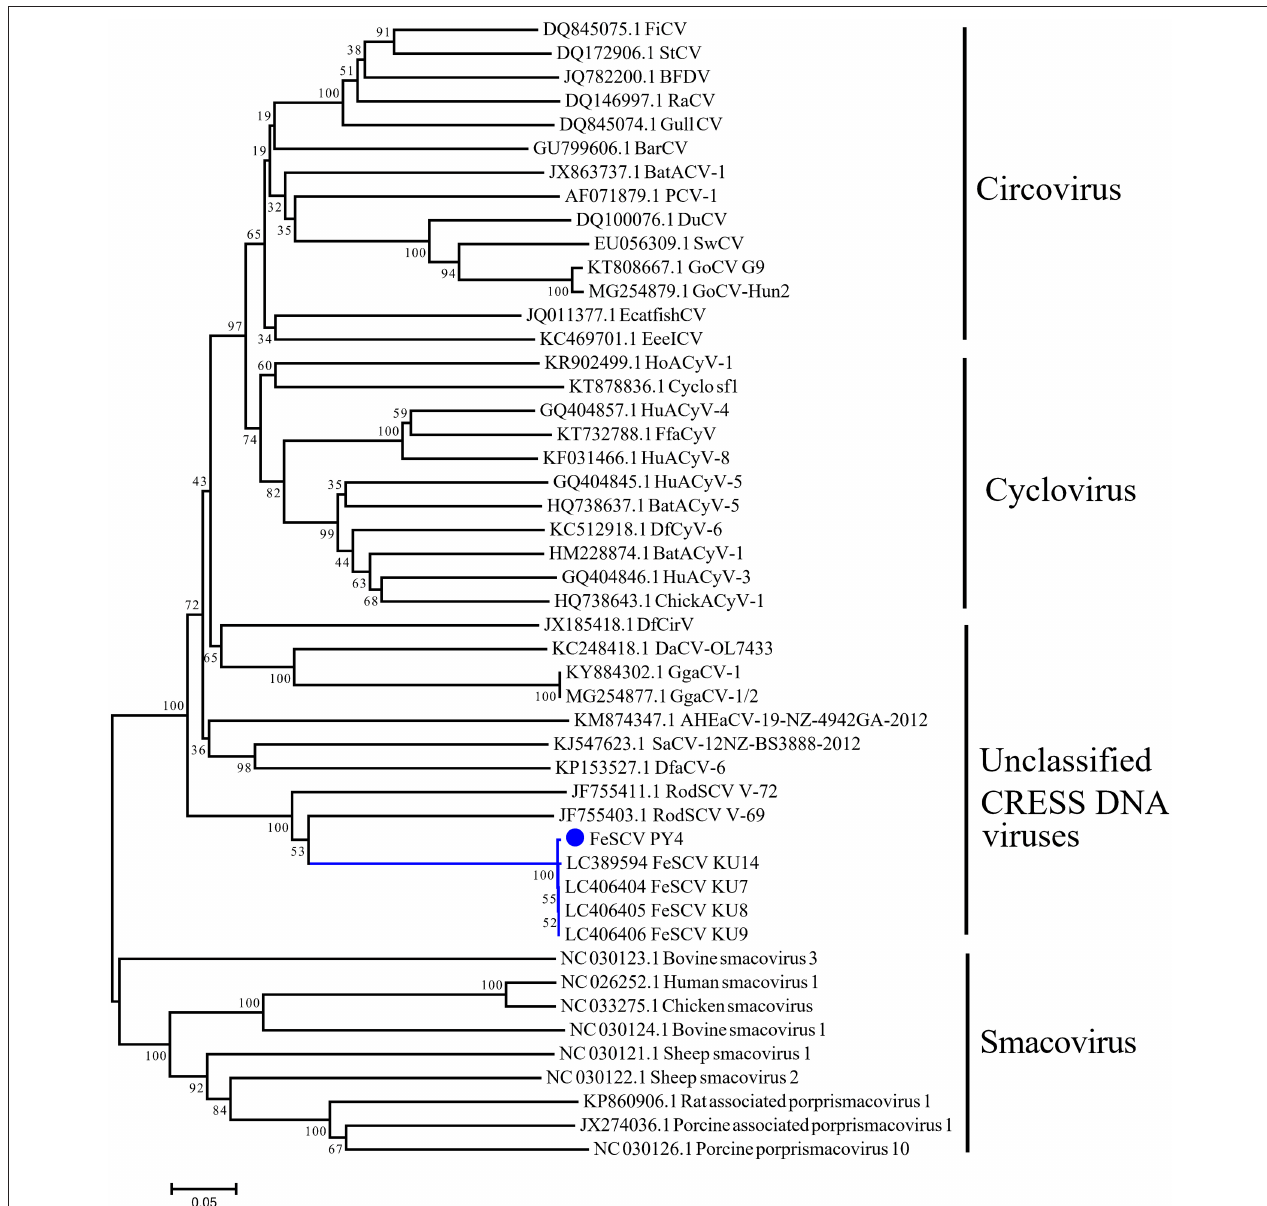
FIGURE 2 | Neighbor-joining tree based on the Rep amino acid sequences of CRESS DNA viruses. The tree was constructed using the neighbor-joining method carried out in MEGA 7.0.26 with bootstrap tests of 1,000 replicates (p-distance model). The blue dot indicates the virus identified in this